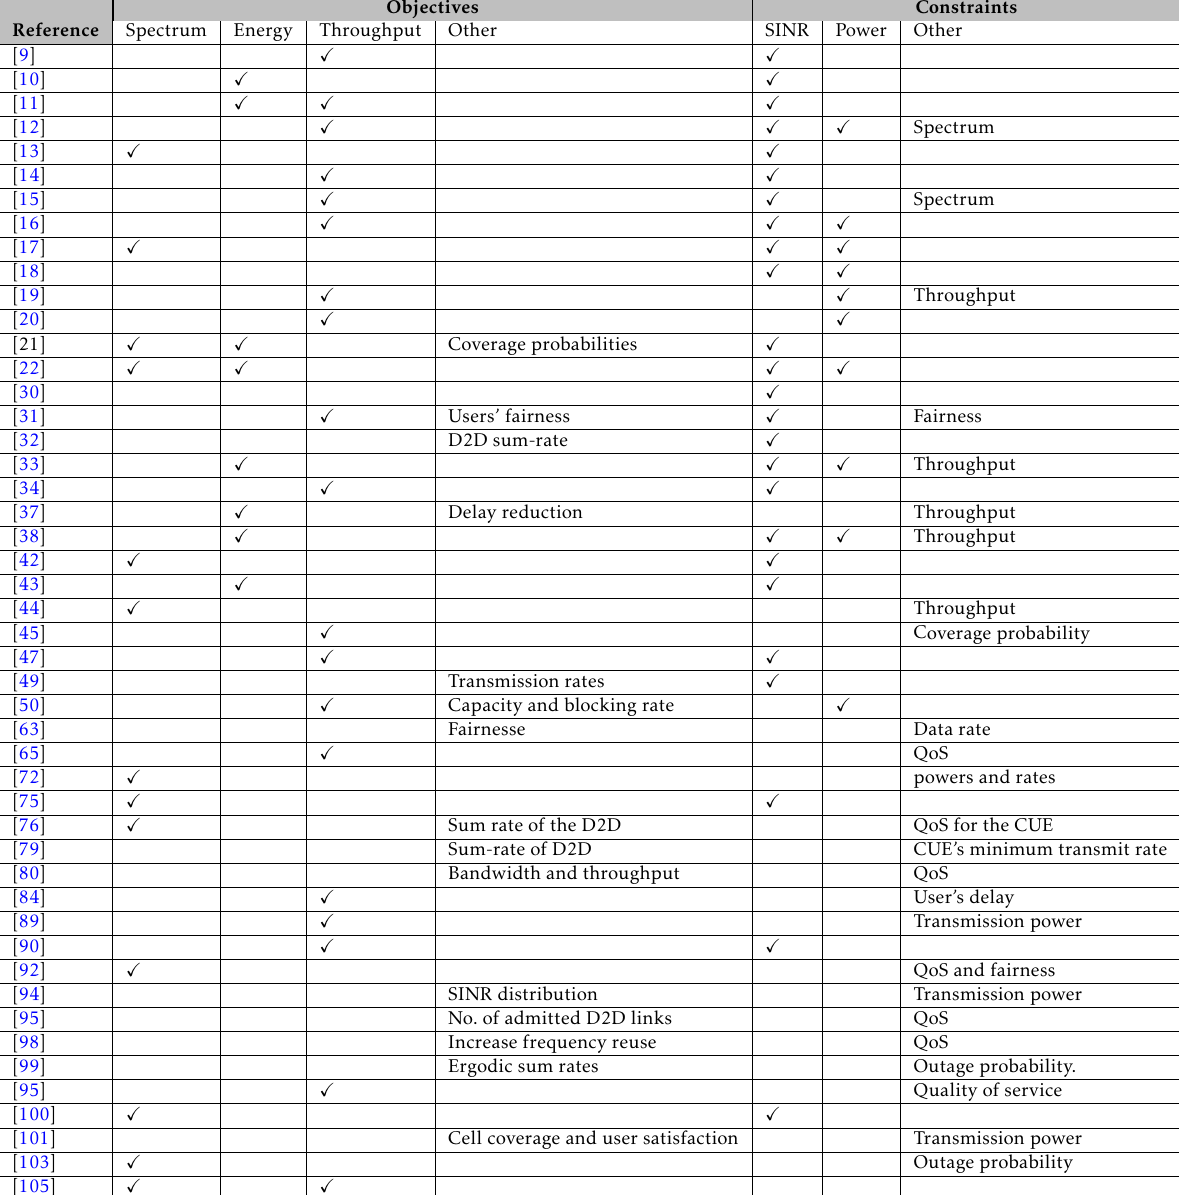
Table 10. Resource Allocation in inband D2D communication: Comparison Based on Objectives and